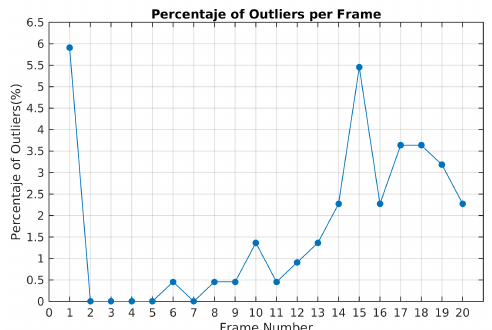
Figure 16. Ratio of outliers with TbD-SfM method for Scene